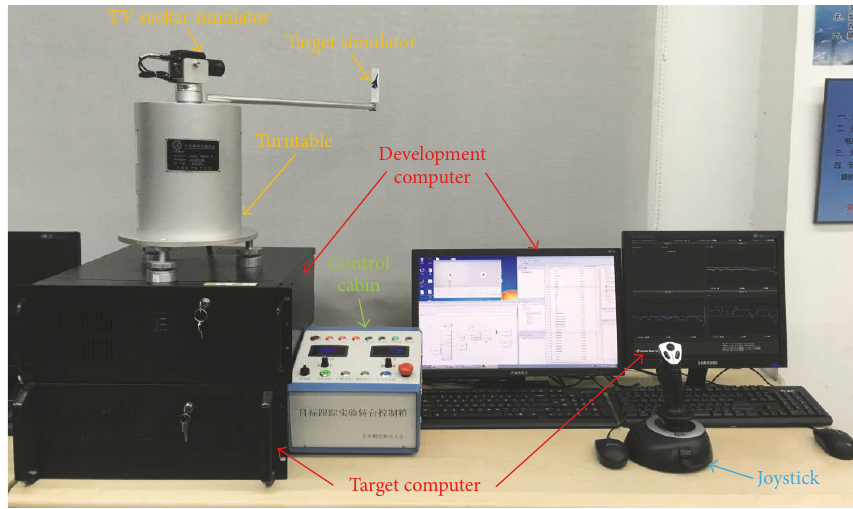
Figure 1: The new HIL simulation platform.